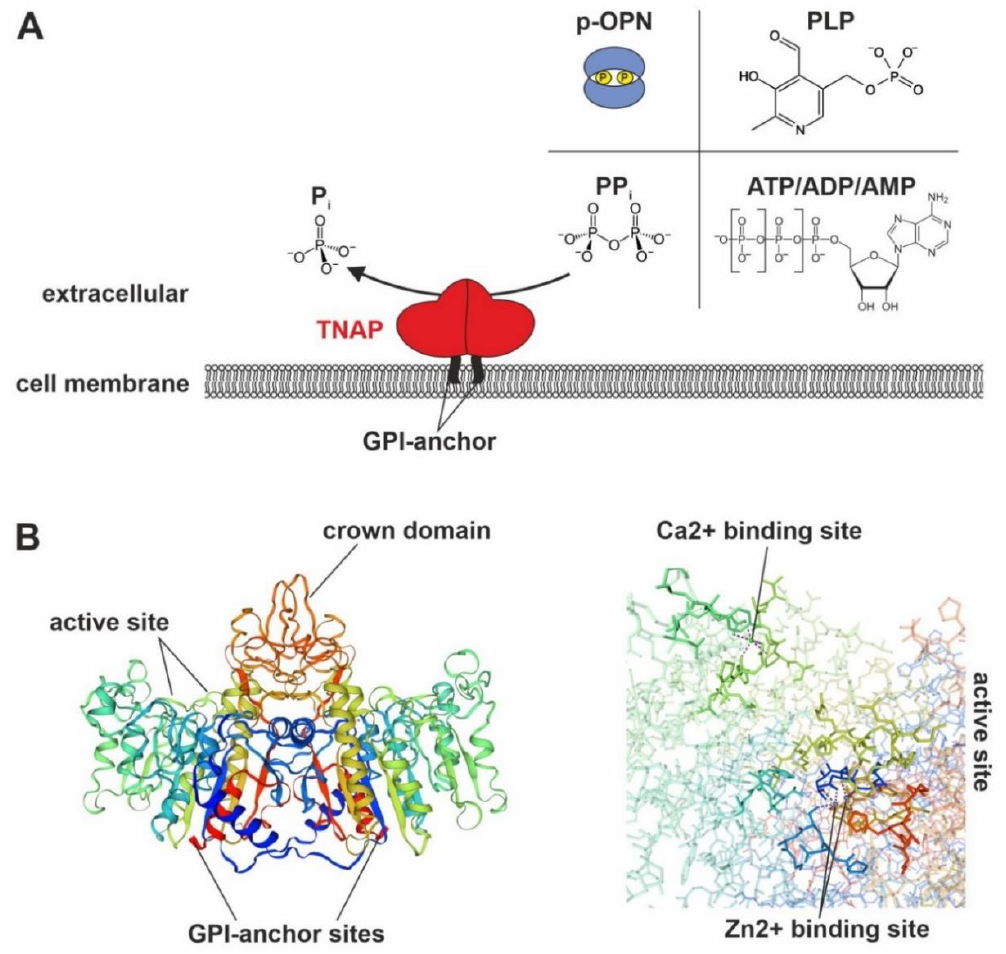
Figure 1. Potential enzymatic functions and structural visualization of TNAP. ( A ) Depiction of potential TNAP substrates. ( B ) Schematic depiction of a predicted homology model of TNAP’s dimerized